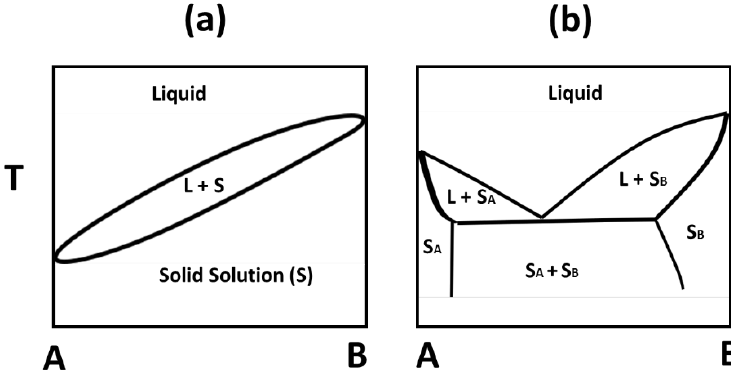
Figure 1. Model schematic of two types of phase diagram in binary mixtures of triacylglycerols (TAGs); ( a ) monotectic, continuous solid solution, ( b ) eutectic phase behavior (redrawn from [23] with copyright permission).